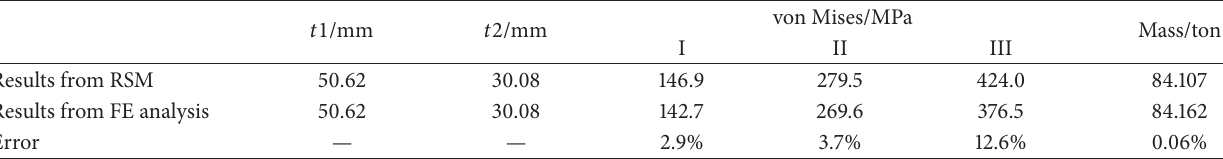
Table 5: Results comparison of RSM and FE analysis.